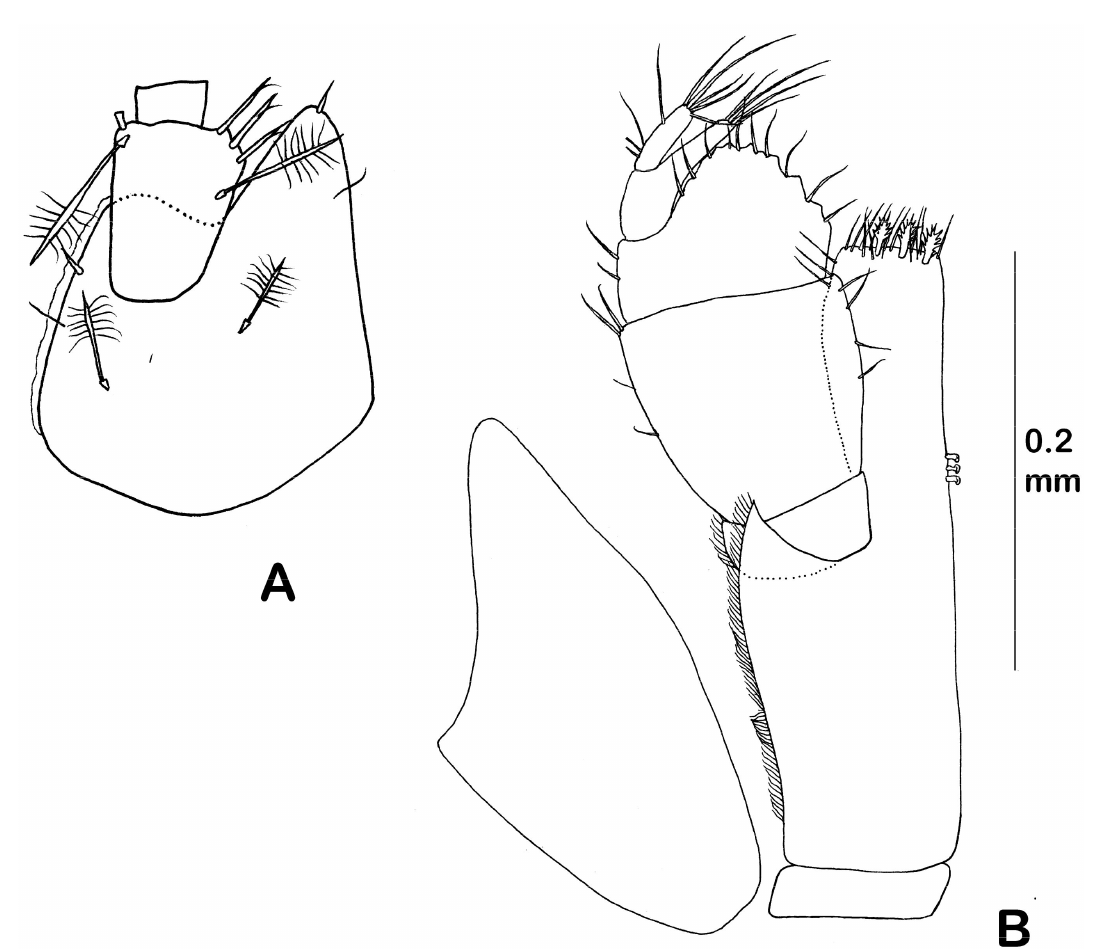
Figure 36. Eurycope mathiasi sp. nov. Female paratype (ZMH K-45662): ( A ) antenna I, articles 1 and 2. Female paratype (ZMH K-45663): ( B )